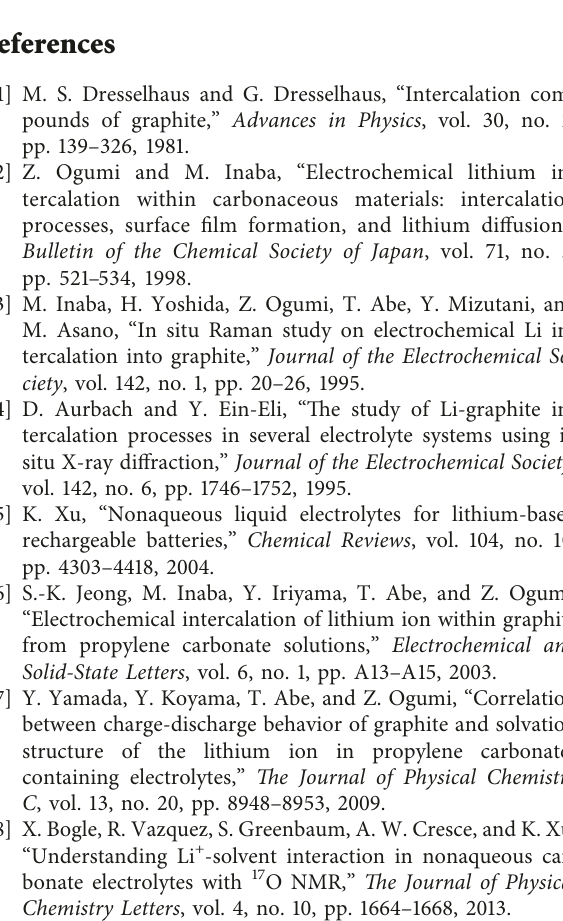
Figure 6: In situ Raman spectra of HOPG recorded during the first reduction in constant-current mode (1C) in 1M electrochemical cell was charged to ∼ 20mAh